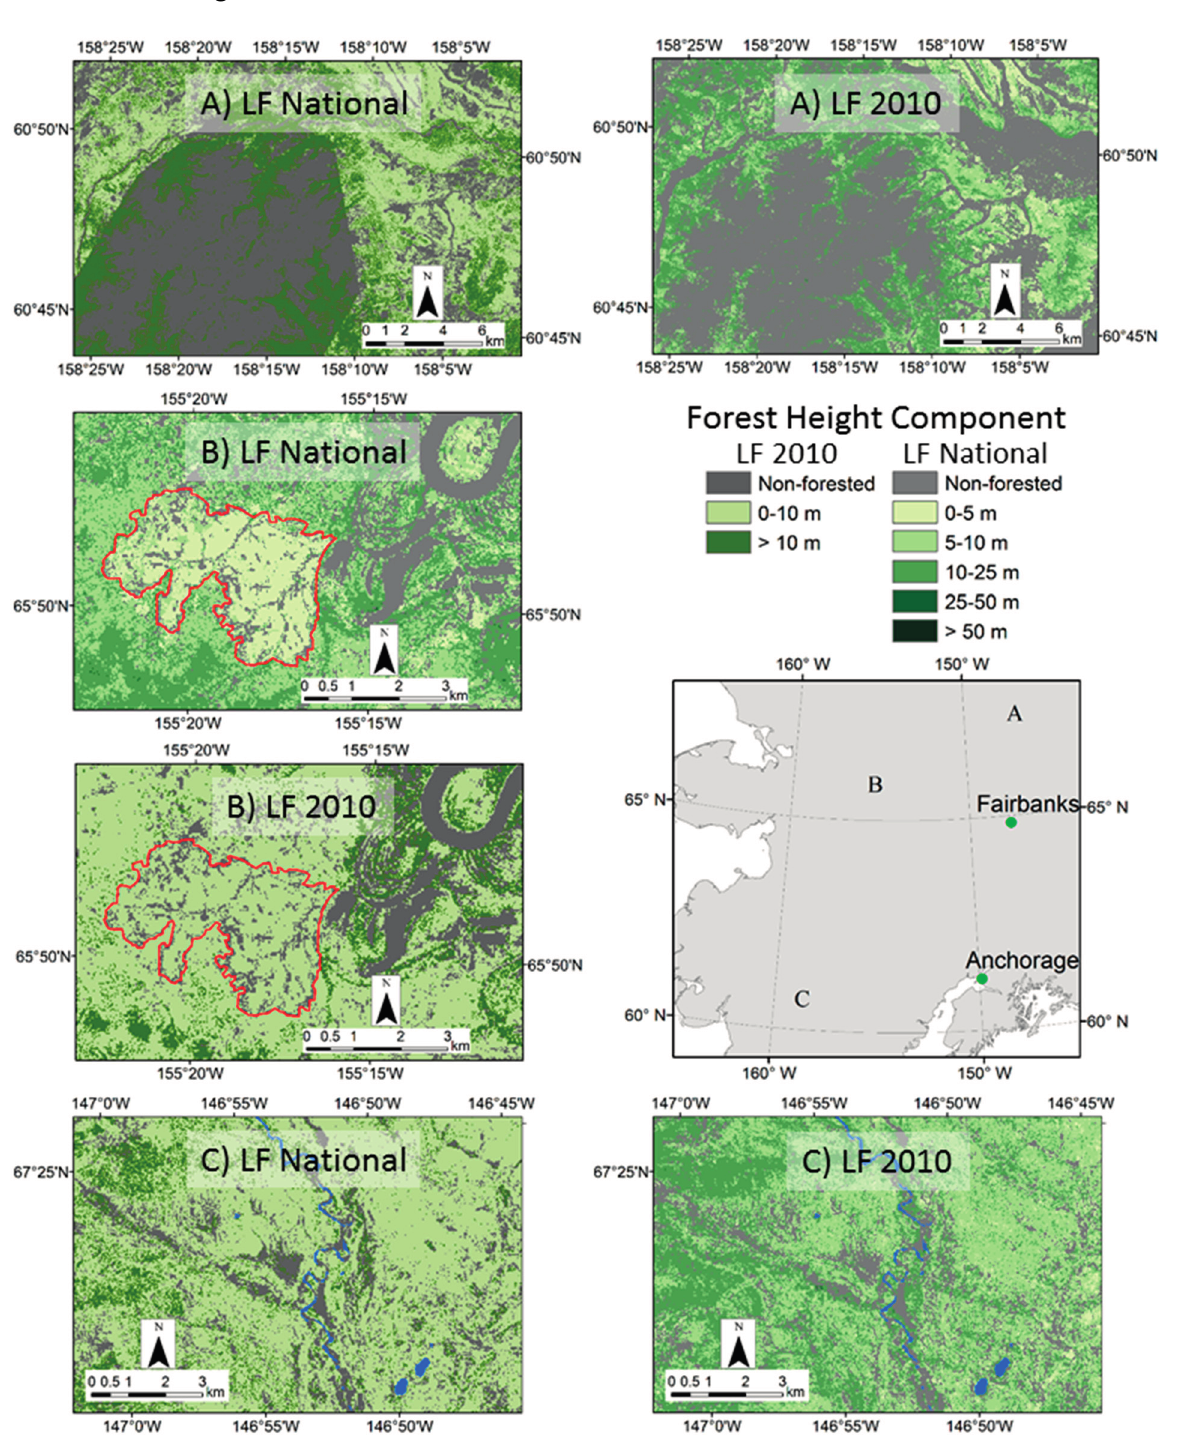
Figure 8. Examples of qualitative improvements in the LF2010 FHC map vs. LANDFIRE National original. ( A ) shows an improved representation of a vegetation structure patterns associated with a riparian corridor, ( B ) shows a better representation of structural change resulting from a fire (burn perimeter shown in red), and ( C ) shows the mitigation of seamlines using the new